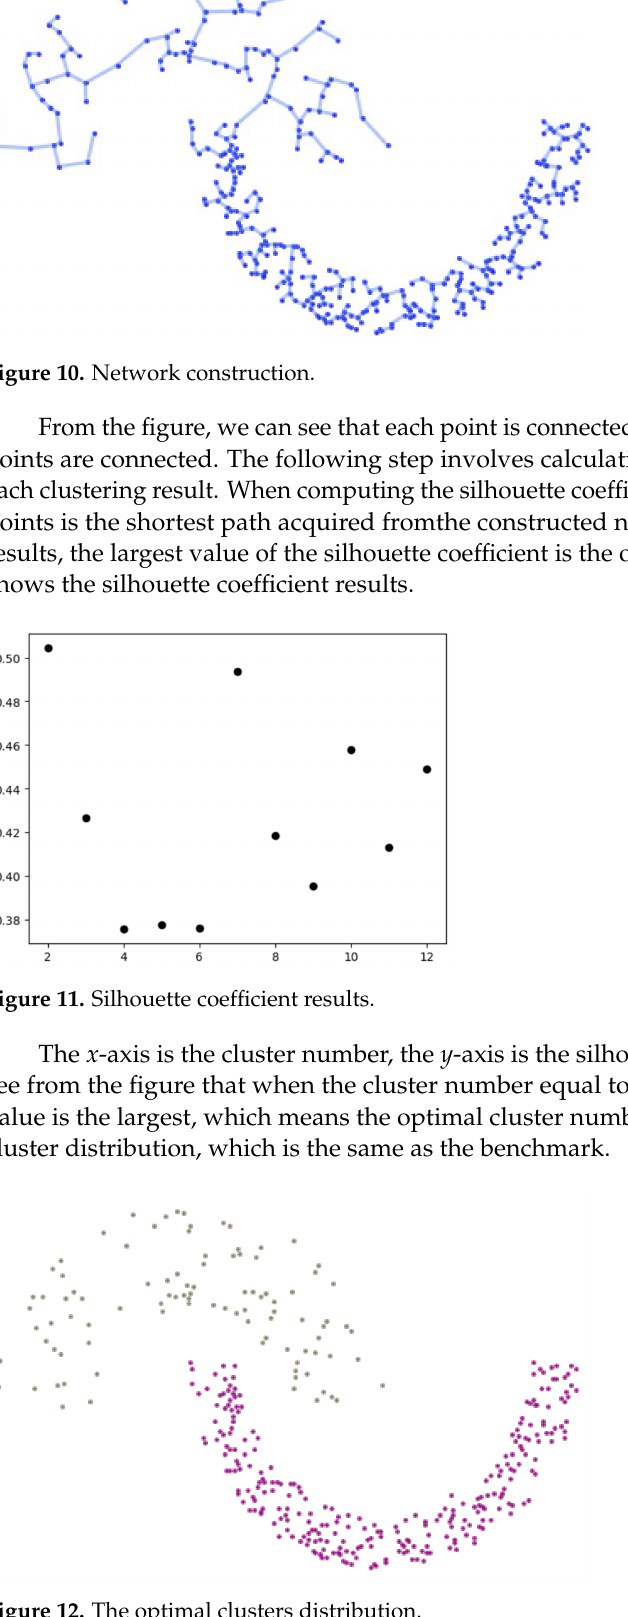
Figure 12. The optimal clusters